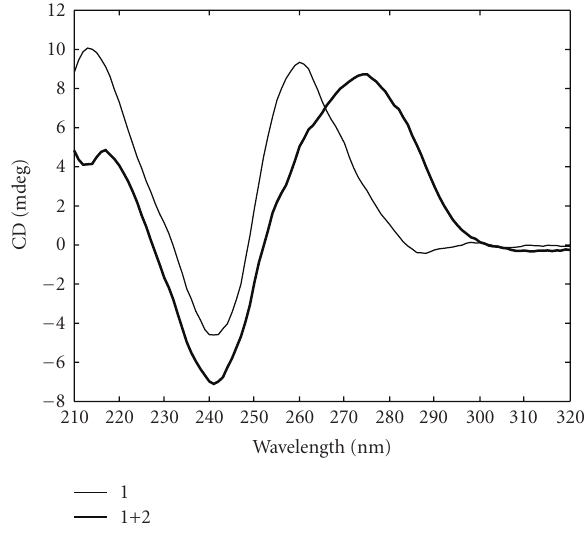
Figure 2: Circular dichroism spectra of parallel clamp 1 and the complex formed by 1 and its target 2 (Conditions 50mM MgCl 2 , 10mM sodium cacodylate pH